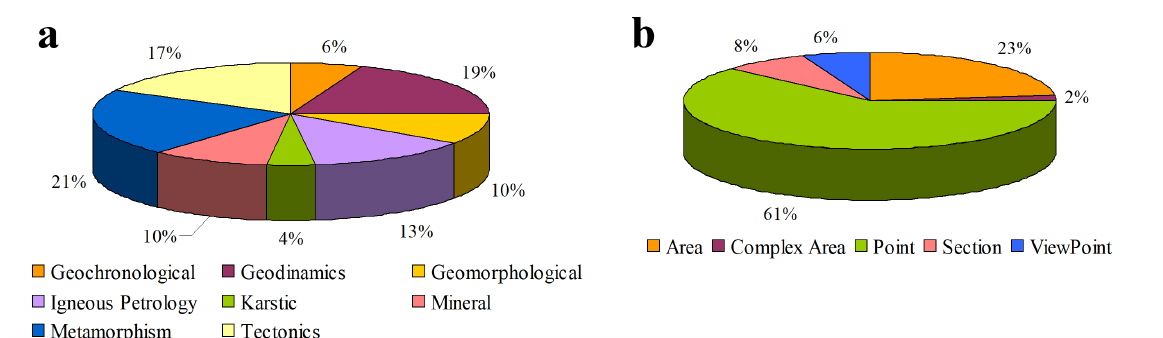
Figure 4 - a ) Distribution of geosites according to main geological interest. b ) Distribution of geosites according typological categories of Fuertes-Gutiérrez and Fernández-Martínez (2010).